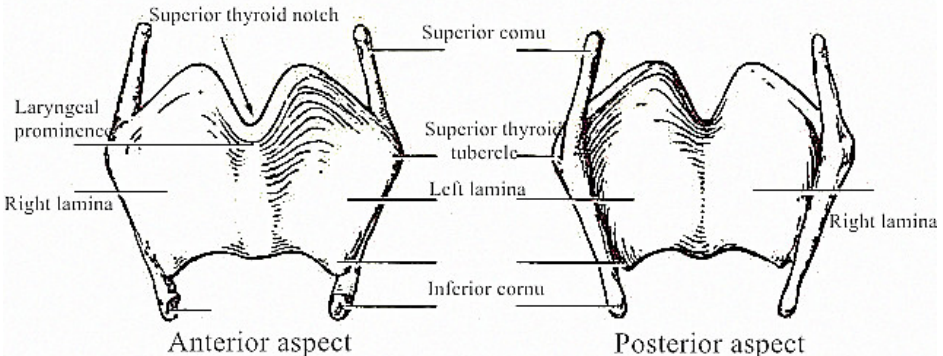
Figure 2. Thyroid